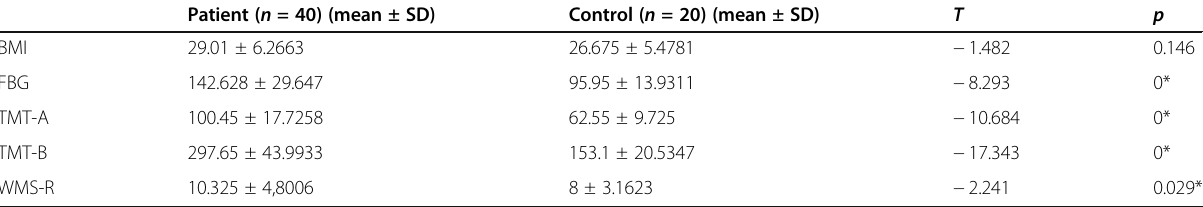
Table 1 Cognitive function and metabolic profile of the case and control groups